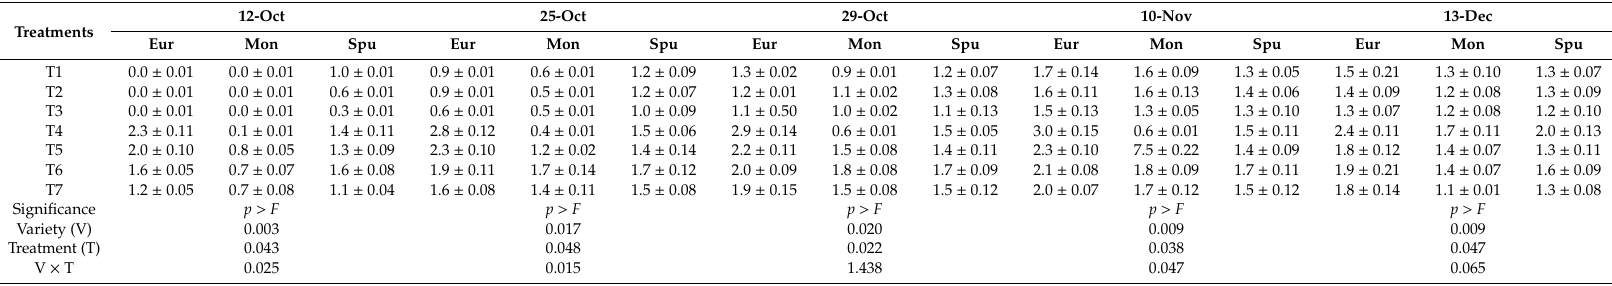
Table 7. Average ( ± standard error) number of stems per plant (no.) of three varieties (Europa, Monalisa, and Spunta) subjected to seven pre-planting dormancy-breaking treatments and accross di ff erent monitoring dates (Experiment 1).